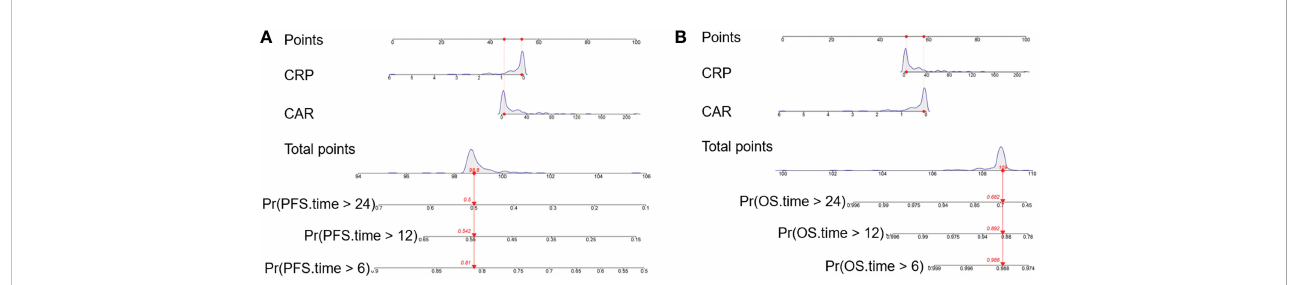
FIGURE 6 Nomogram model for predicting the (A) PFS and (B) OS of R/M CC patients receiving tislelizumab with CRP and CAR. The nomogram was formulated based on the fi nal Cox proportional hazard regression model and conducted using the package of rms in R. And it was used summing the points identi fi ed on the points scale for each variable. Red lines and dots are drawn upward to determine the points received by each variable. The total points projected on the bottom scales indicate the probability of 6-month, 12-month and 24-month survival (PFS and OS). PFS, progression-free survival; OS, overall survival; R/M CC, recurrent or metastatic cervical cancer; CRP, C-reactive protein; CAR, CRP-to-albumin ratio; Pr,